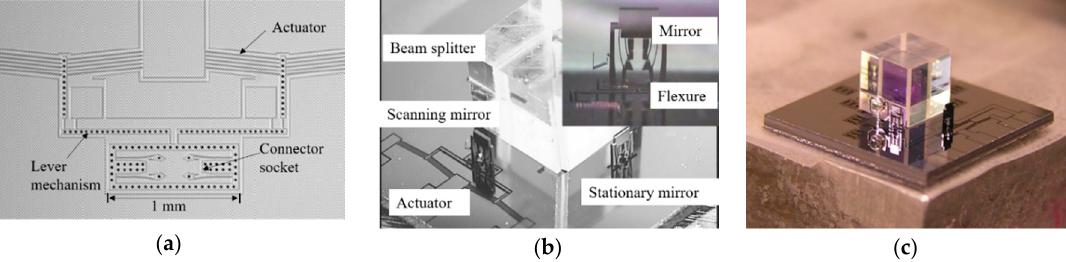
Figure 26. ( a ) An electrothermal scanning mechanism with a lever mechanism; ( b ) an assembled FTS; ( c ) an assembled FTS with a ball lens. (Reprinted with permission from Reference [49] SPIE).